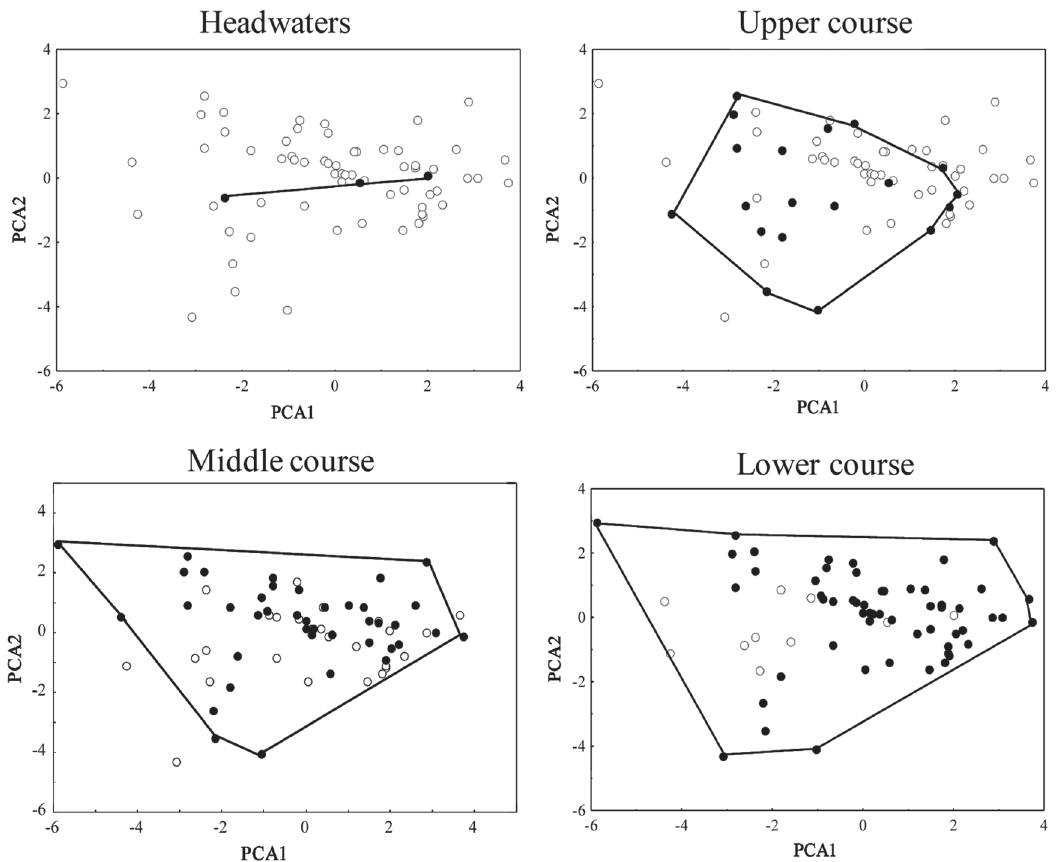
Fig. 2. Projection of the first two principal components based on 11 fish morphological attributes for the headwaters, upper course, middle course and lower course of the rio das Velhas.